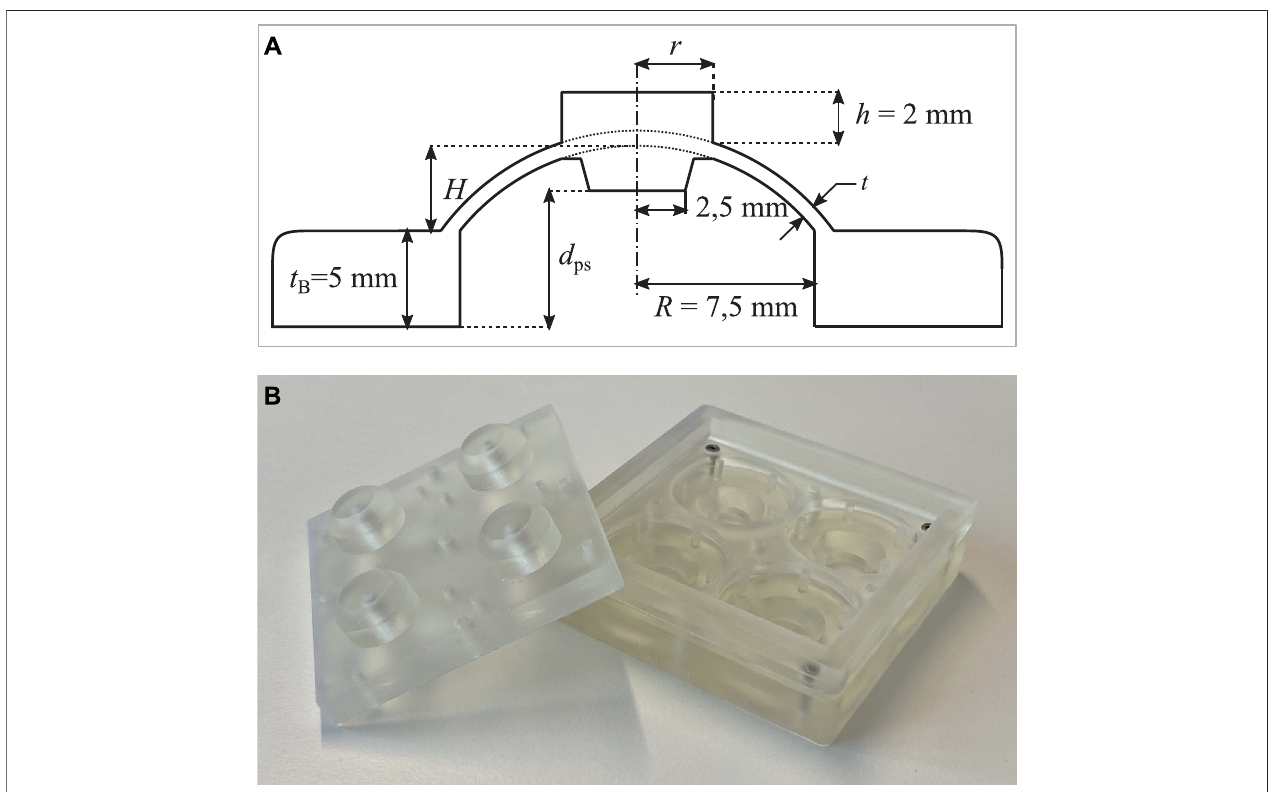
FIGURE 5 | (A) Cross-sectional sketch of the dome geometry, with all the relevant parameters. Note how r , t , and H are left free to design. (B) Picture of a partly assembled 3D printed mold.